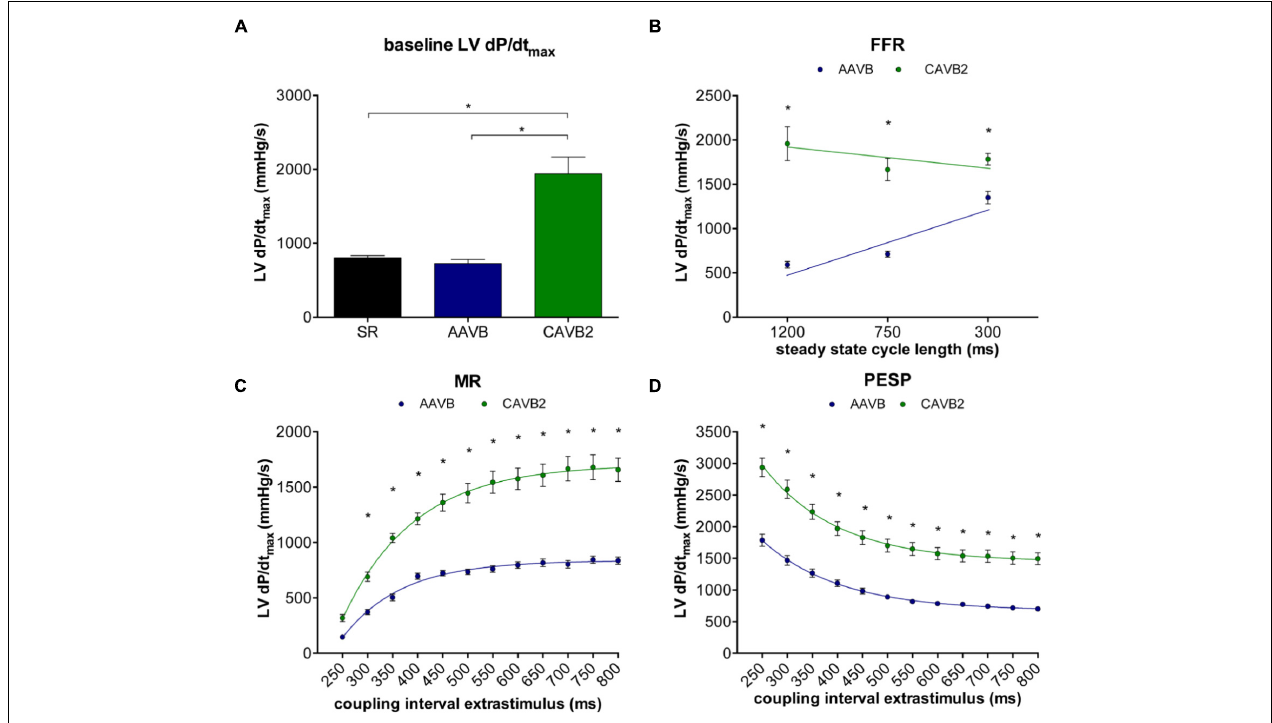
FIGURE 2 | Contractile parameters at acute AV-block (AAVB) and chronic AV-block (CAVB2). (A) LV dP/dtmax at baseline. (B) Force-frequency relationship (FFR). (C) Mechanical restitution (MR). (D) Post-extrasystolic potentiation (PESP). ∗ p < 0.05 compared to AAVB.